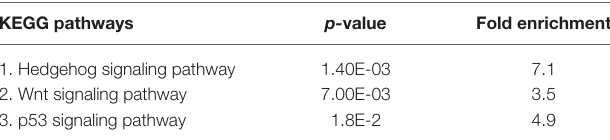
TABLE 1 | Comparison of KEGG pathway analysis of hypoxia + hypothermia vs. hypoxia ranked according to p -value and fold enrichment for differentially expressed genes in